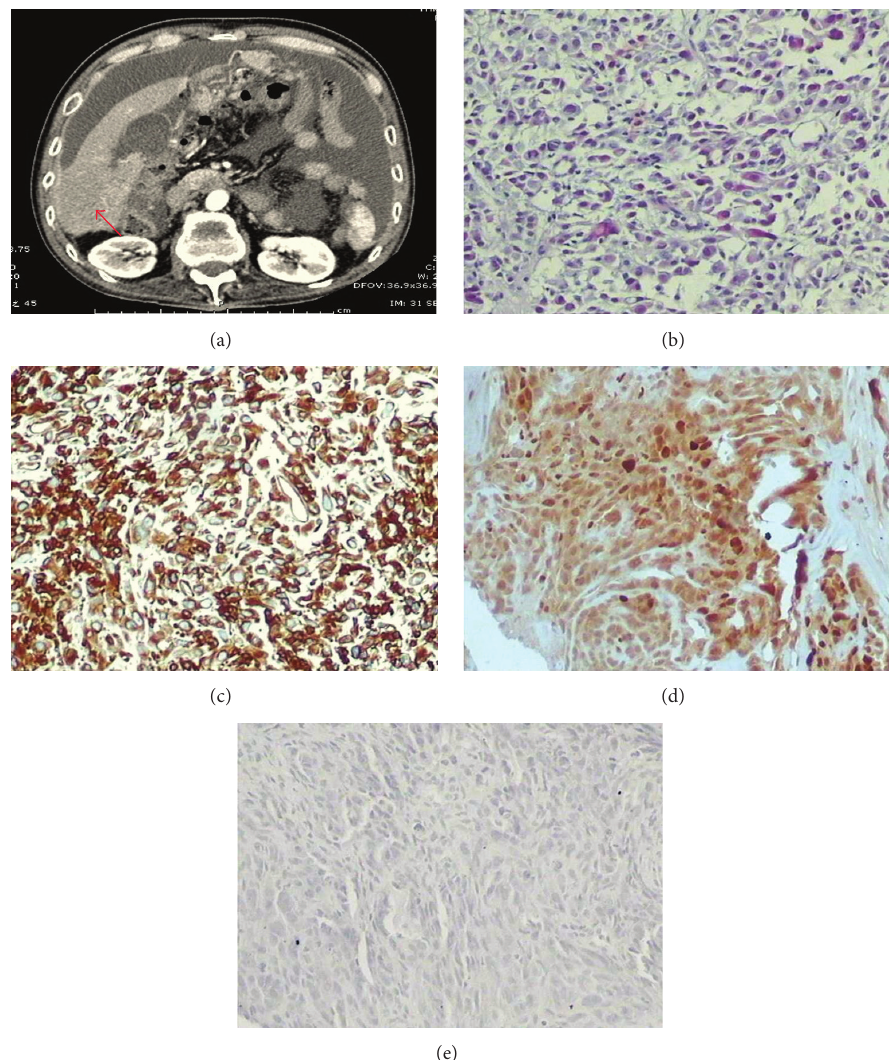
Figure 1: Abdominal CT and cytohistological features on H&E-stained specimens or immunohistochemical stains for case 1. (a) Abdominal CT demonstrated a mass in the hepatic flexure of colon with invasion into the liver (red arrows). (b) Cytohistological features of the greater omentum biopsy on H&E-stained specimens. Immunohistochemical stains showed that the tumour cells were positive for cytokeratin (c) and calretinin (d) but negative for carcinoembryonic antigen